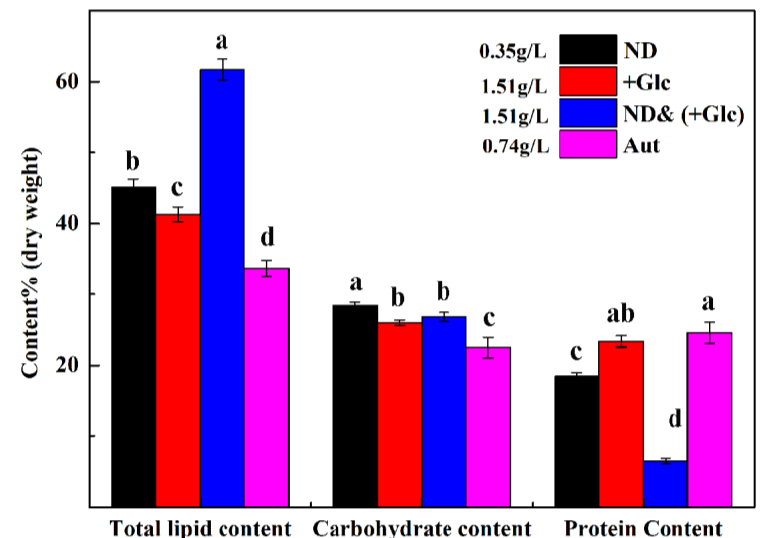
Figure 5. The content of total lipid, carbohydrate, and protein in P. kessleri TY under different culture conditions on day 7. (The dry weight (g/L) of different culture conditions is displayed in the figure. Values with the same letters are not significantly different at the same time ( p < 0.05)). (Mean ± SEM, n = 3). Table 2. Lipid productivity of P. kessleri TY under different culture conditions on the 7th d .